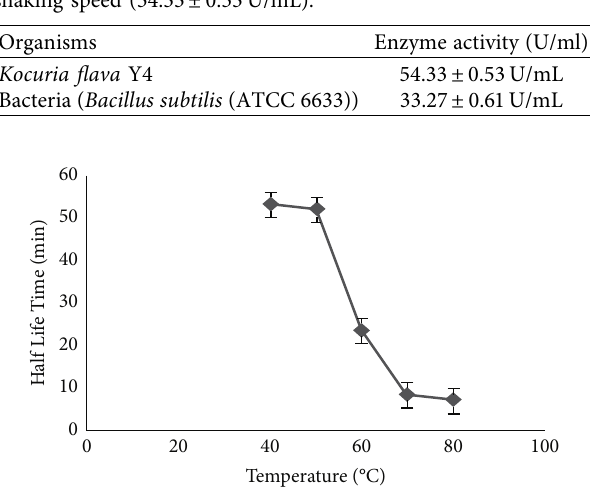
Table 5: Comparison of enzyme activity of K . flava Y4 lipase with bacterial lipase Bacillus subtilis (ATCC 6633) at optimum pH